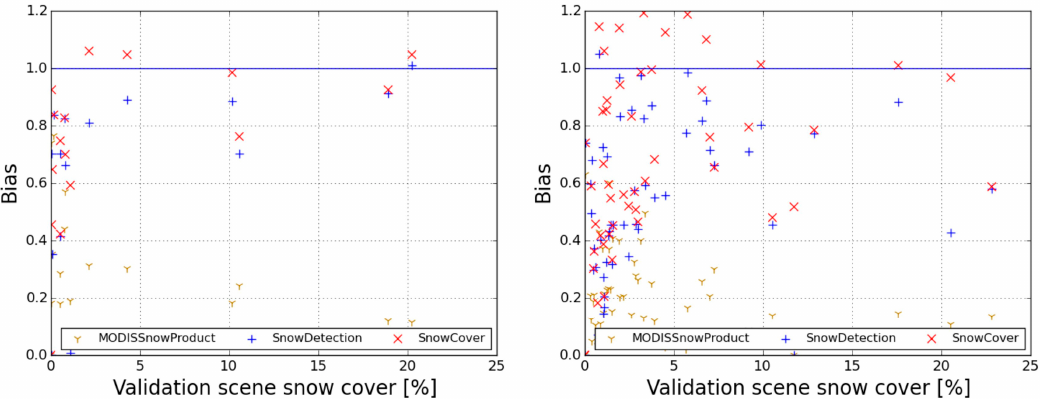
Figure 4. Calculated bias between validation source ( left : Landsat; right : MERIS) and snow cover derived from MODIS data (MOD09GA) with the application of NDSI (red x-marks represent “snow detection”) and after temporal and spatial post-processing (blue x-marks represent “snow cover”). For comparison the quality of the MODIS standard snow product (MOD10A1) is shown with brown x-marks.